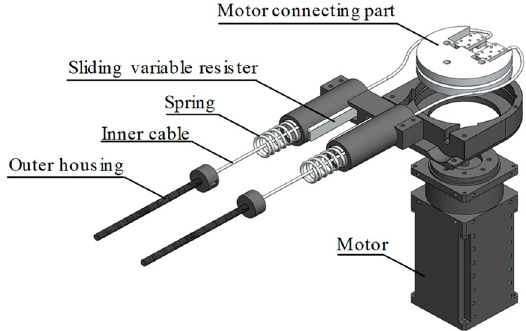
Figure 2. Exploded diagram of the torque output section.